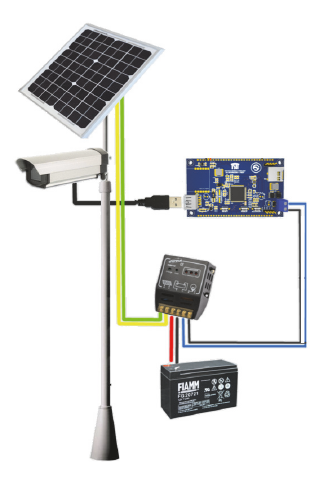
Figure 8: VSN sensor node prototype with energy harvesting system.